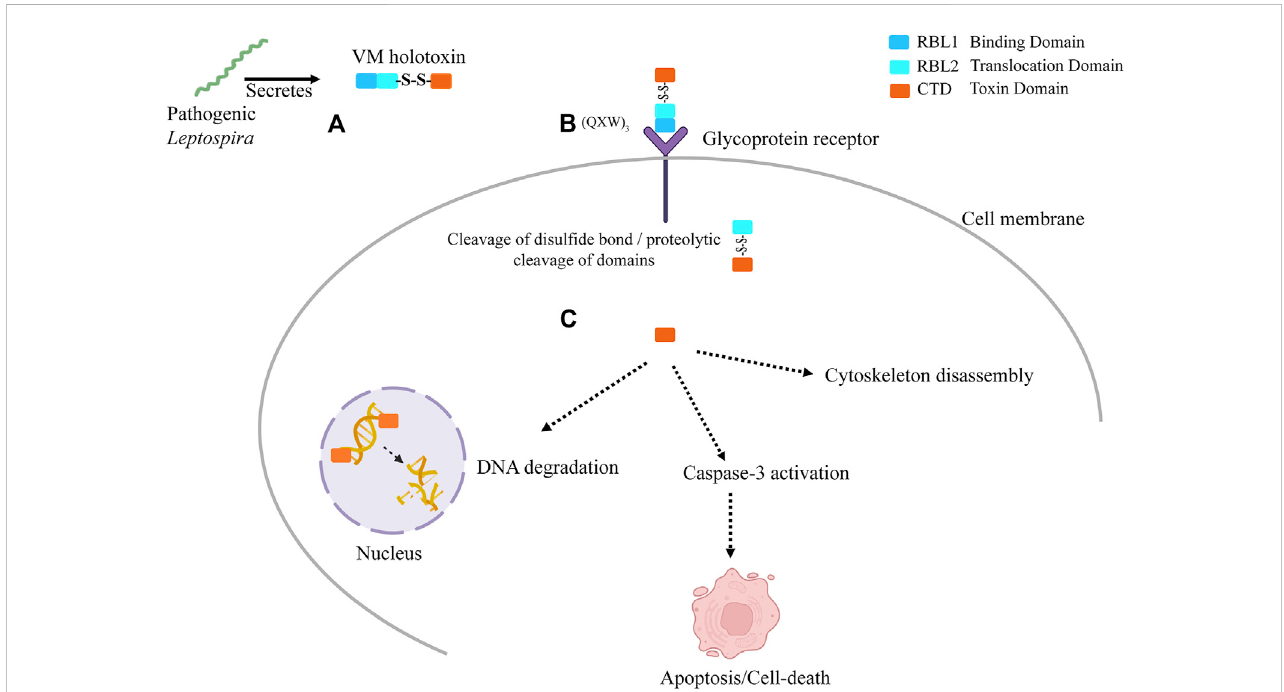
FIGURE 9 The graphical presentation of proposed hypothetical model: VM proteins have myriad functions that contribute to leptospirosis pathogenesis. (A) Pathogenic Leptospira secrete exotoxins. These exotoxins are multi-globular domain AB-toxins encoded by a single gene. The N-terminus possesses ricin B-like lectin domains (RBL1 and RBL2) with multiple disul fi de-bonds and functional DNase domains at the C-terminus containing a single disul fi de bond. (B) The VM protein binds to terminal galactosyl-containing glycoproteins of the host cell surface via RBL1 domain comprising carbohydrate binding characteristic lectin family sequence motif (QxW) 3 and aromatic patches, located at N-terminal and then translocated inside the host cell plausibly by RBL2 translocation domain. (C) The VM protein must undergoes proteolytic cleavage, which is essential to produce the functional domains. The cleavage of disul fi debondfurtherreleasesthefunctionaltoxindomaininthecytosol.Nuclearlocalizationsignaldirectthetoxindomainintothenucleuswhereitdisrupts the chromosomal integrity. The secondary effects such as cytoskeleton disassembly and caspase-3 activation plausibly led to apoptosis and